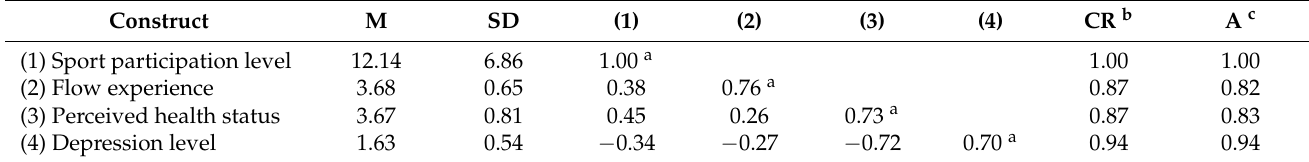
Table 2. Reliability, convergent and discriminant validity of measurement